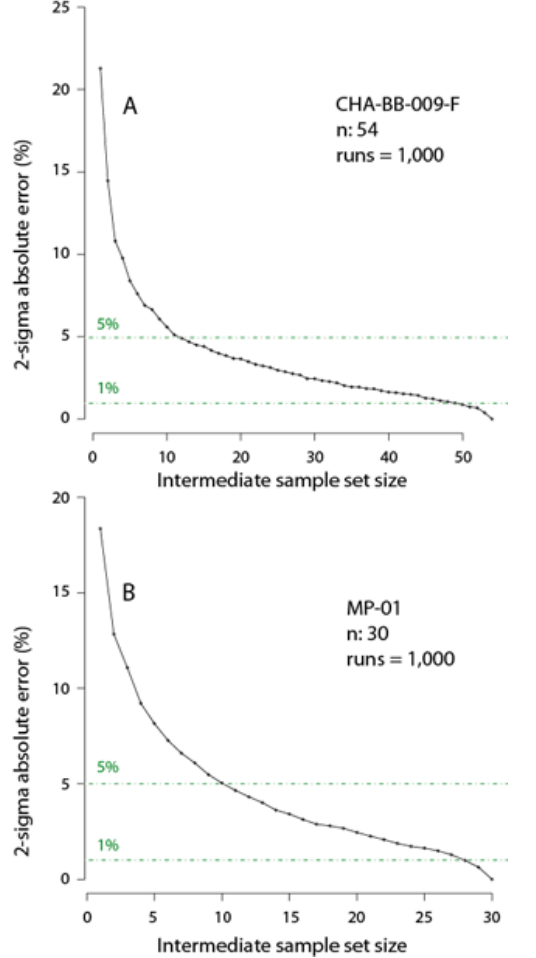
Figure 2. Stability curves obtained after 1000 runs for two samples from Chachimbiro and Unzen data sets. Note the constant slope be- low the 5%